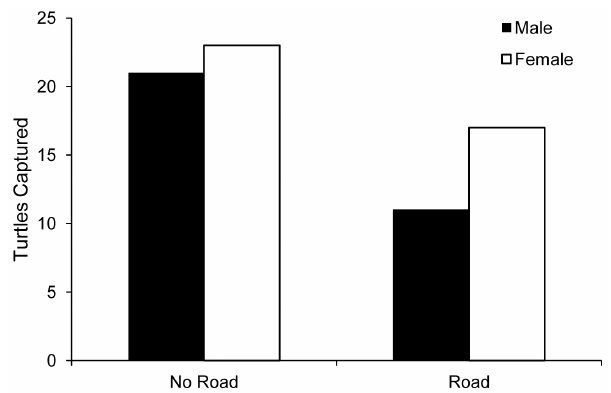
Figure 5. Numbers of male and female turtles captured at Road and No Road sites.